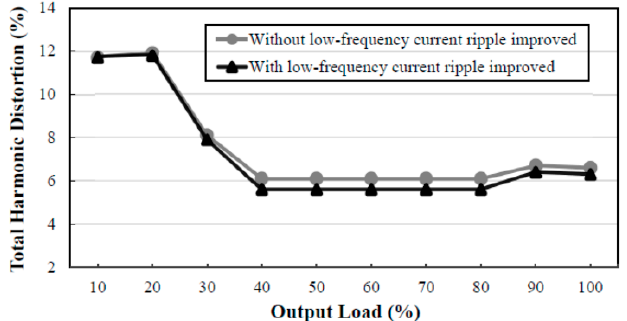
Figure 15. Curve of total harmonic distortion versus output load under 110 V input voltage.